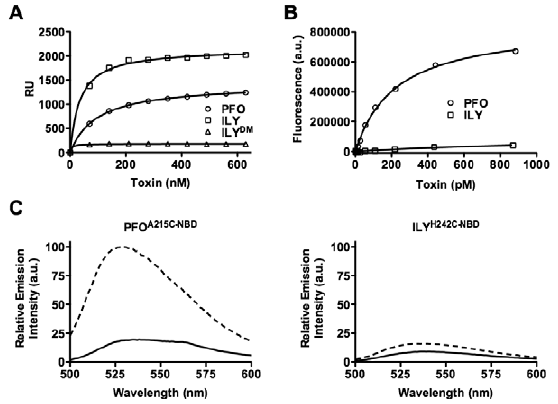
Figure 7. ILY binding and pore formation on cholesterol-rich liposomes. (A) Binding of PFO, ILY and ILY DM to cholesterol-rich POPC liposomes was measured by SPR. The data is representative of 3 experiments. (B) Pore formation on liposomes was measured as the emission intensity of CF increased upon dilution as pores are formed in the liposomes. The change in the emission intensity of CF over time in an untreated sample was subtracted from the experimental data. The data are representative of at least 3 analyses. ILY DM contains glycine substitutions for the ILY CRM residues Thr-517 and Leu-518, which knocks out CRM-dependent binding to cholesterol-rich membranes [22].(C) To measure the insertion of the b -barrel pore a cysteine was substitutedand modified with NBDfor TMH1 residue Ala-215 of PFO or its analog, His-242 in ILY. Each derivative was incubated in the presence (dashed line) and absence (solid line) of cholesterol-rich liposomes. As the soluble monomer binds to and forms a pore in the membrane the NBD probe positioned in TMH1 makes the transition from a polar environment in the soluble monomer (solid line) to the nonpolar environment of the membrane (dashed line), which is reflected by an increase in the NBD fluorescence emission [27].